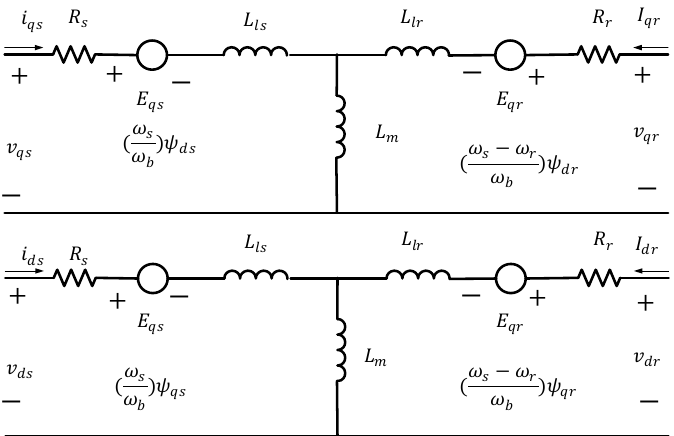
Figure 4. Equivalent circuit of DFIG in synchronous reference frame.